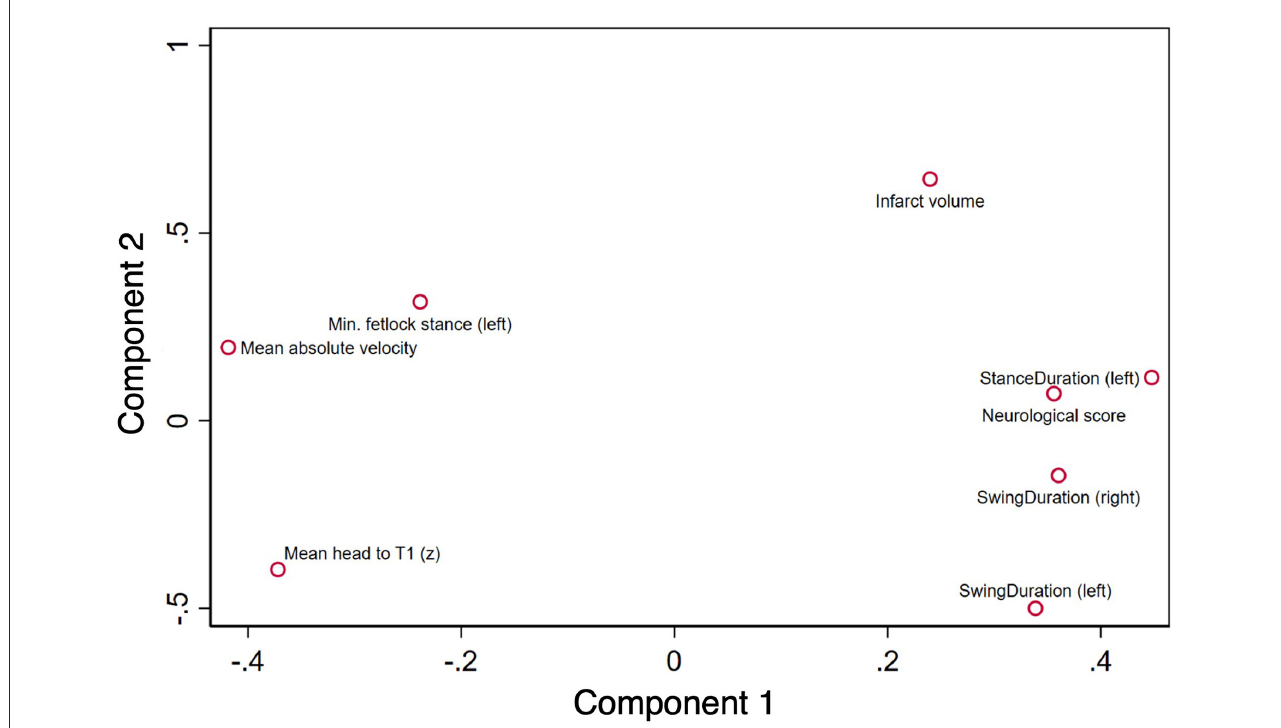
FIGURE4 Principal component analysis loading plot for variables. Principal component 1 shows positive associations with stance duration (left forelimb), total neurological score, swing duration (left and right forelimbs); and negative associations with mean head to T1 and mean absolute velocity. Principal component 2 relates positively to infarct volume and minimum fetlock stance (left forelimb); and negatively to swing duration (left forelimb) and mean head to